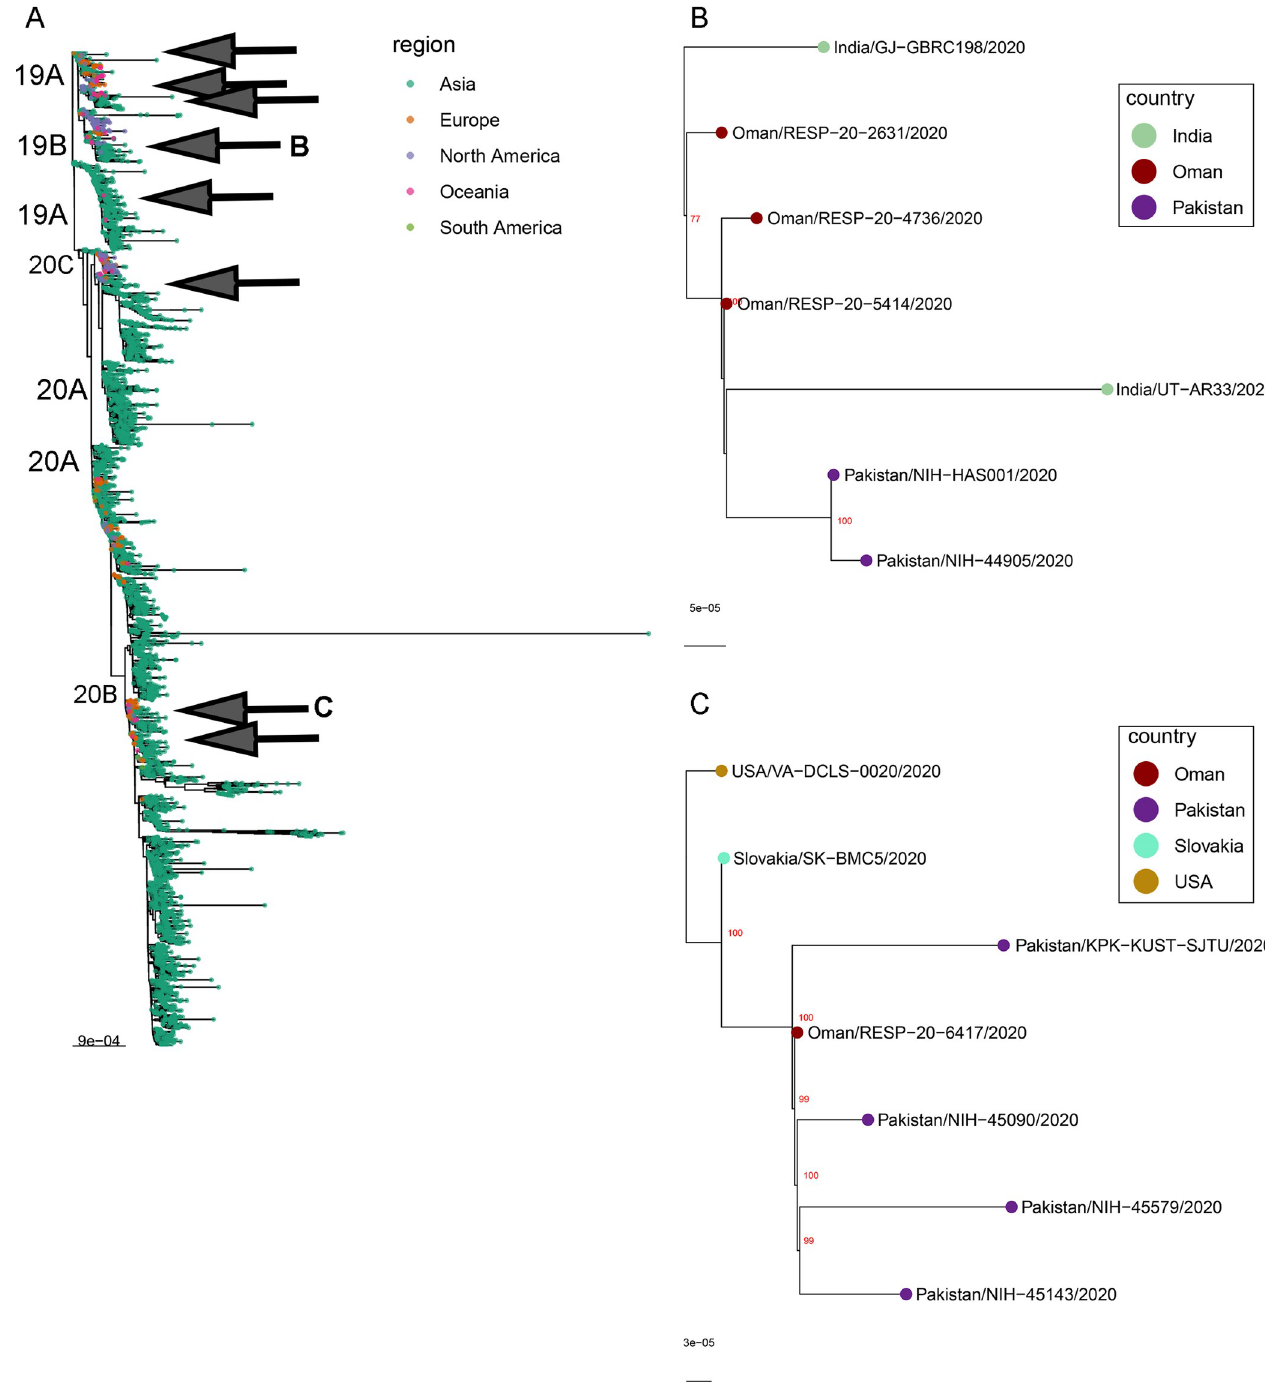
Fig 2. Inference of SARS-CoV-2 phylogenetic relationships. The phylogenetic tree was reconstructed using Maximum Likelihood method with bootstrap 1000 replicates (A). Globally subsampled SARS-CoV-2 genomes supplemented with additional complete genomes from countries surrounding Pakistan were included. Pakistani strains are highlighted with grey arrows. B) Expansion of clade containing sequences NIH-44905 and NIH-HAS001. C) Expansion of clade containing sequences NIH-45090, NIH-45579, and NIH-45143.